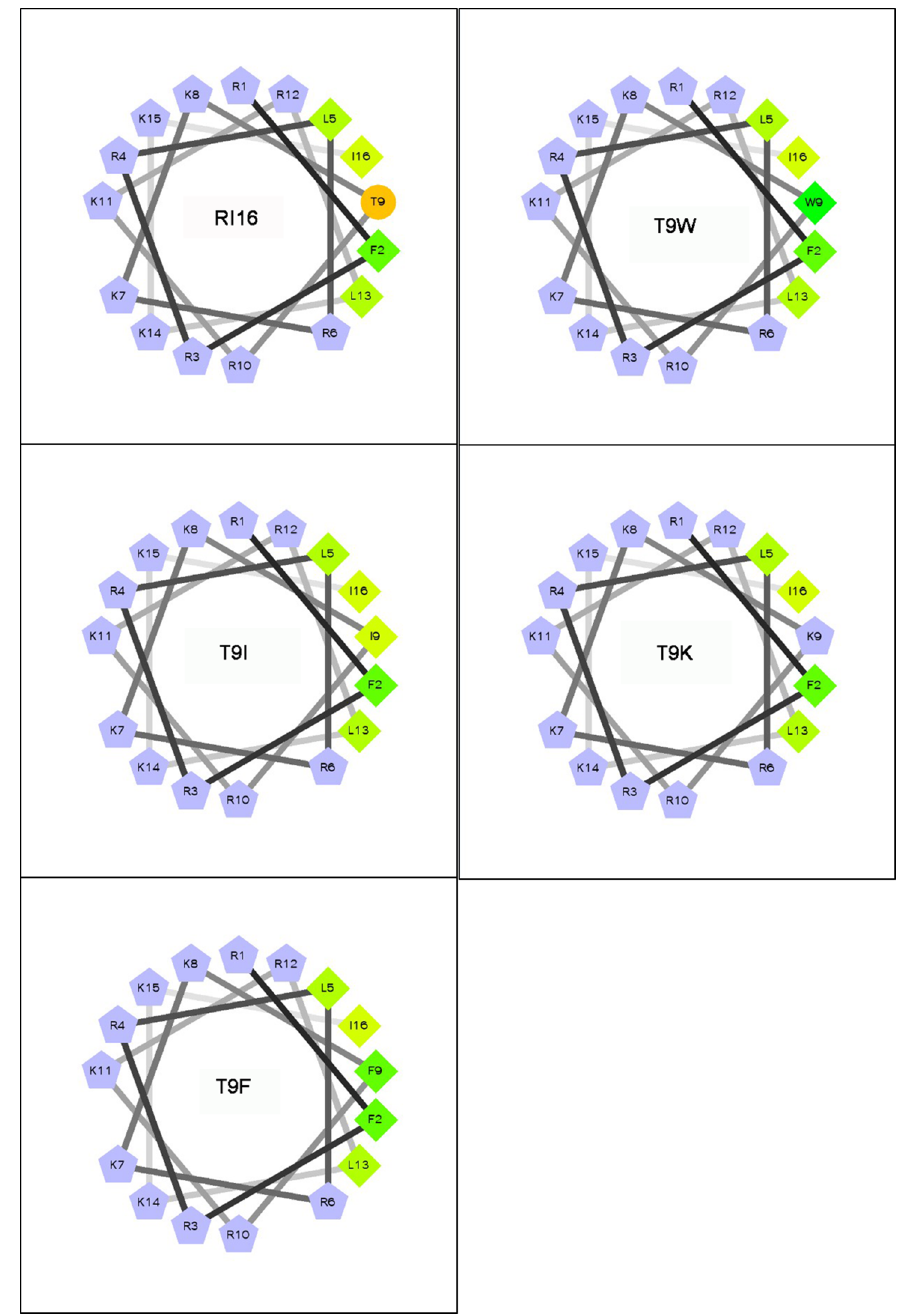
Fig. 1. Helical wheel projections of the peptides. By default the output presents the hydrophilic residues as circles, hydrophobic residues as diamonds, potentially negatively charged as triangles and potentially positively charges as pentagons. Hydrophobicity is color coded as well: the most hydrophobic reside is green, and the amount of green decreases proportionally to the hydrophobicity, with zero hydrpphobicity coded as yellow. The positively charged residues are grey and the hydrophilic residues are coded orange. The wheel projection was performed online using the Helical Wheel Projections: http://rzlab.ucr.edu/scripts/wheel/wheel.